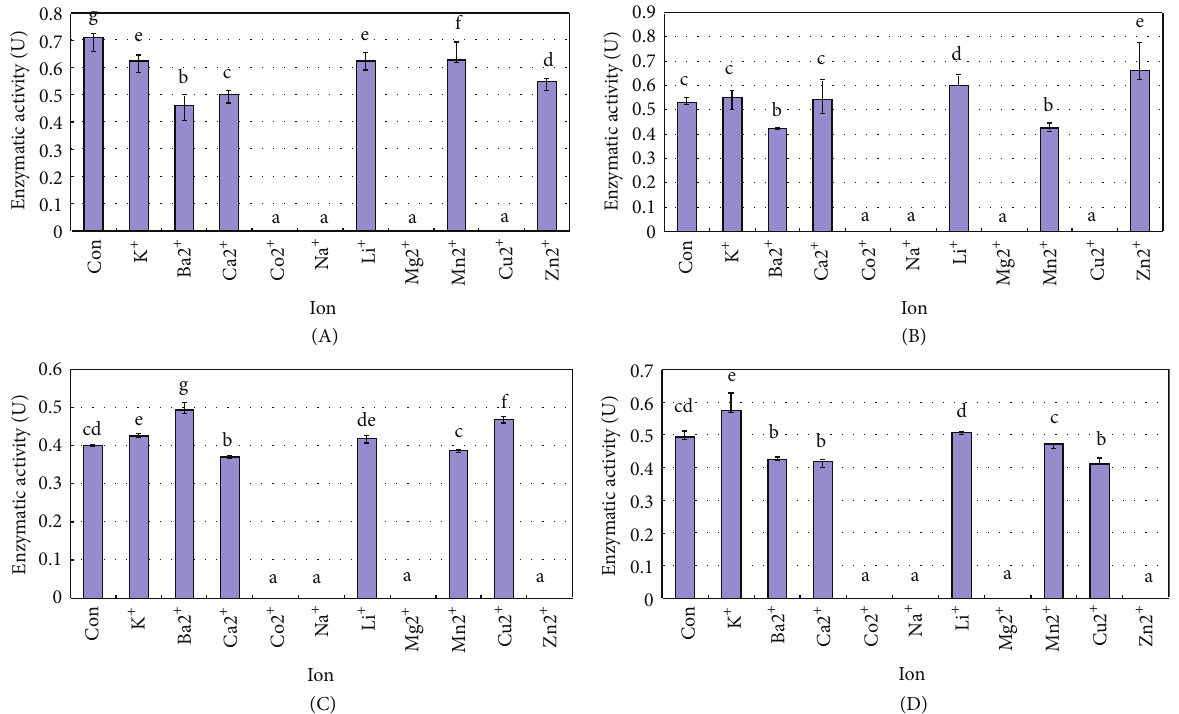
Figure 4: Effects of exposure to different metal ions on the activities of four different recombinases. (A) Activities of recombinase inrCHI31 with different metal ions; (B) activities of recombinase exrCHI31 with different metal ions; (C) activities of recombinase inrCHI32 with different metal ions; (D) activities of recombinase exrCHI32 in the presence of different metal ions. Several different reaction buffers were prepared, each spiked with 5mmolL −1 of each metal ion. The chitinase activities were measured at 37 ∘ C for 20 min. Con: control; the activities of inrCHI31, exrCHI31, inrCHI32, and exrCHI32 were measured under normal reaction conditions without any additional ions. The experiments were performed three times. Different letters above the columns indicated a significant difference as determined by Duncan’s multiple comparisons test ( 𝑃 < 0.05